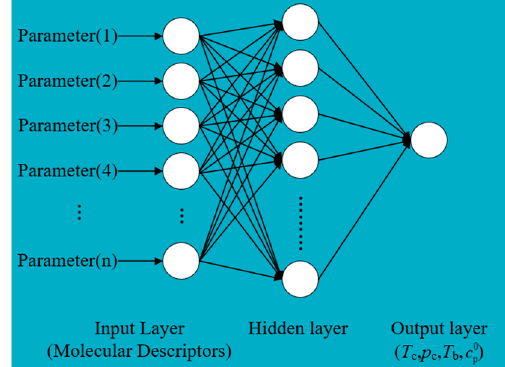
Figure 2. BP neural network schematic diagram.